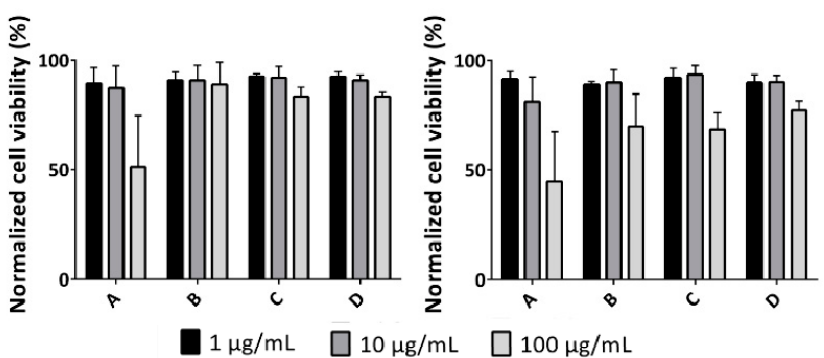
Figure 20. Cell viability of L-929 fibroblasts exposed to different concentrations (1, 10, and 100 µ g/mL) of polymers A , B , C , and D for 24 h ( left ) and 72 h ( right ) with the ratio ( 3 ). The effect of polymers was determined by an MTT assay. Results are expressed relative to the untreated control, which was defined as 100%. Mean ± standard deviation (SD) values from at least three independent experiments are shown.